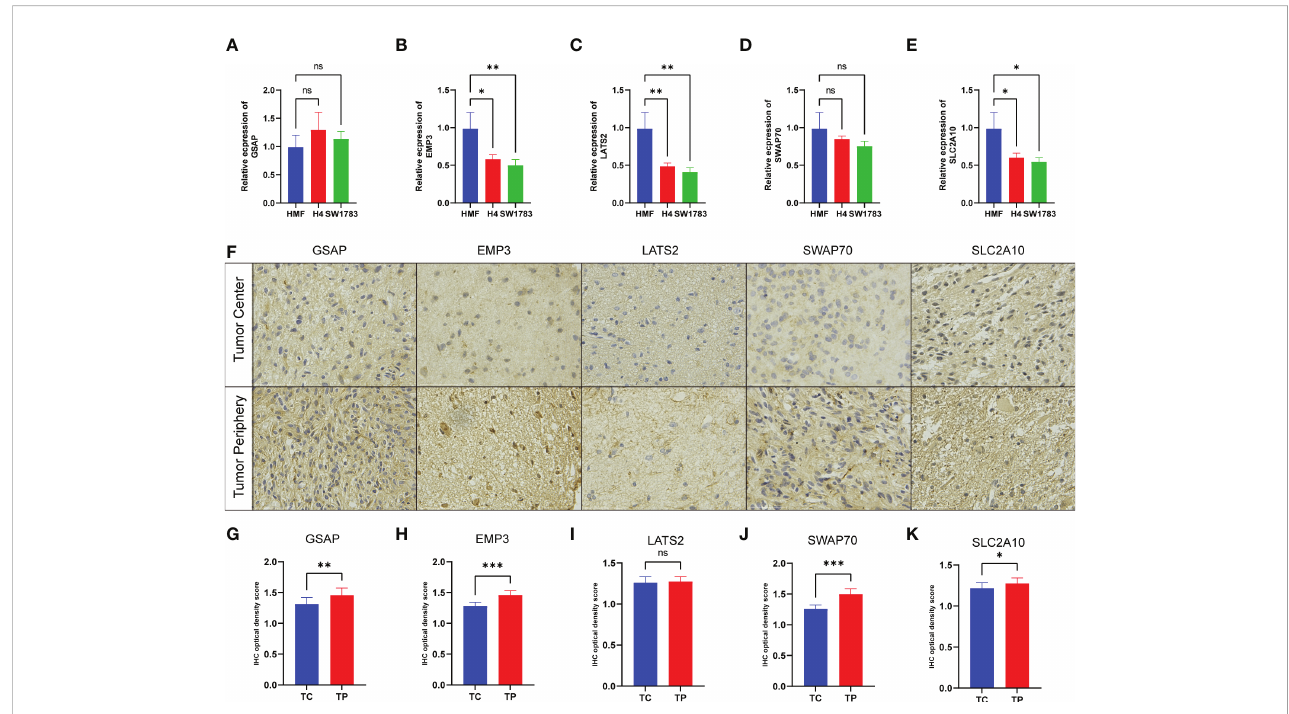
FIGURE 9 Experimental veri fi cation in cell lines and tissues. (A – E) The mRNA levels were determined by qRT-PCR in three cell lines. (F) The expression of fi ve protein comparison of tumor center (TC) vs tumor periphery (TP) sites. (G – K) Bar graph showing the fi ve protein levels obtained by quanti fi cation of immunohistochemical images. (*p< 0.05, **p<0.01, and